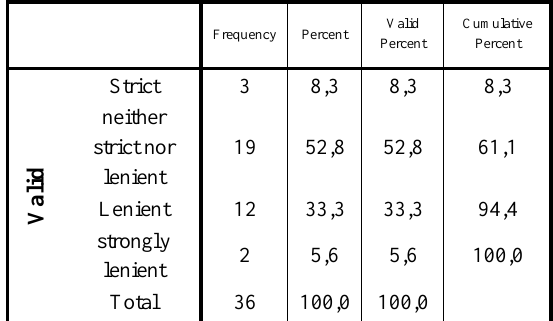
Table 11: Attitude of Professional Accounting Chambers in terms of Errors, Fraud and Ethics